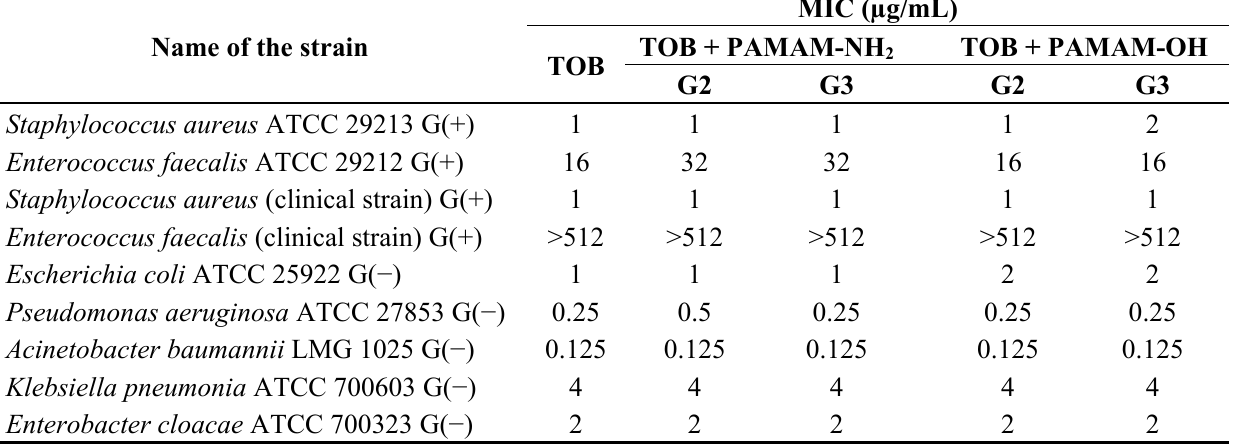
Table 3. Minimum Inhibitory Concentration - MIC (in µg/mL) of tobramycin (TOB) in the presence of PAMAM-NH and PAMAM-OH dendrimers generation 2 (G2) and 2 generation 3 (G3).